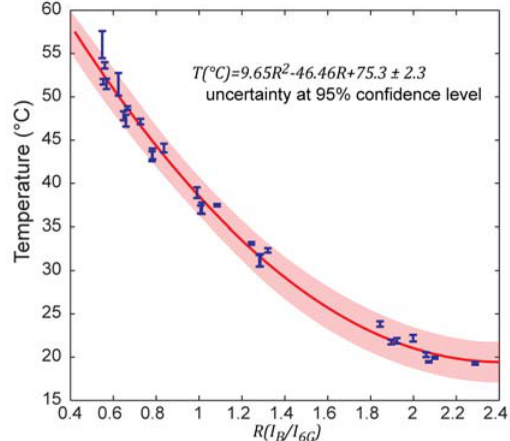
Figure 3. Calibration curve of pipette thermometer, showing the relation between /I and temperature T. Temperature dependent measurements fluorescence intensity ratio I B 6G were carried out in both directions (to account for a possible hysteresis), at two different flow rates and at two different distances of the channel outlets from the bottom plane. All error bars are given for the 95% confidence